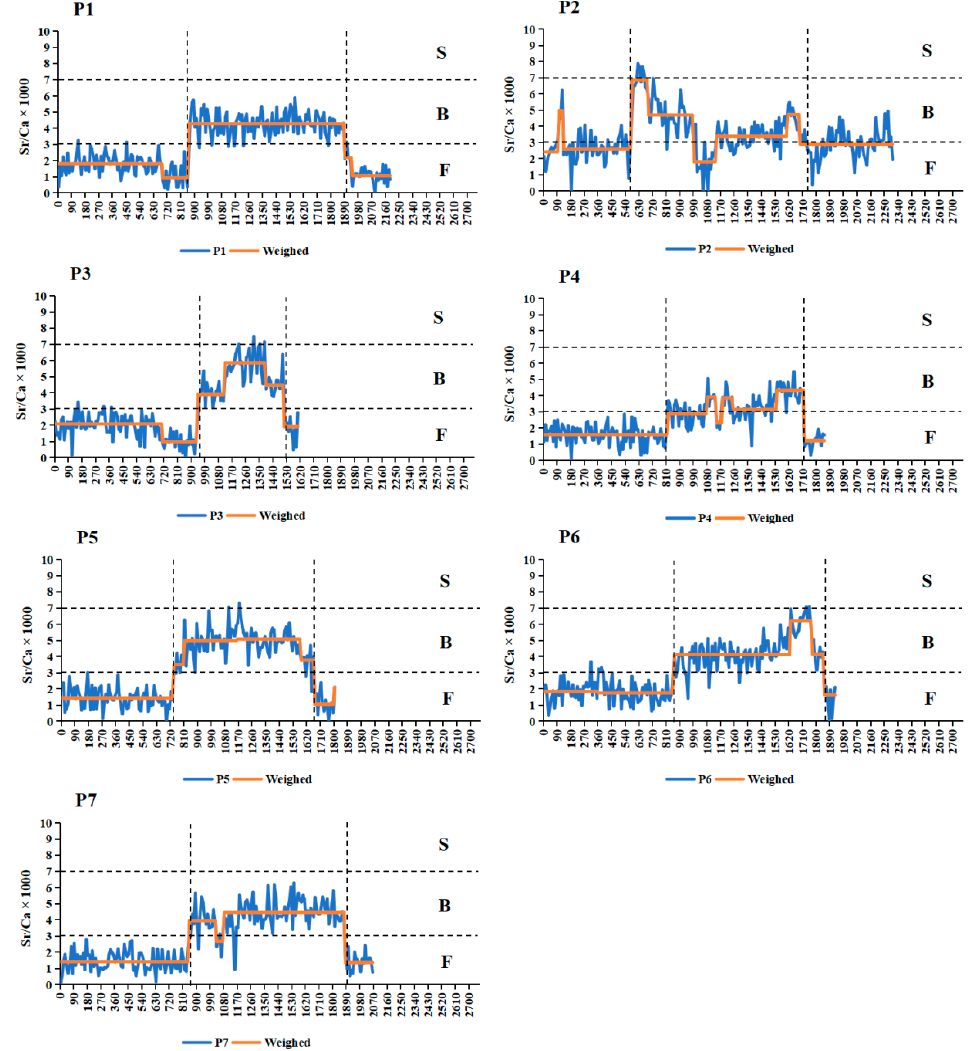
Figure 5. Fluctuation in otolith Sr/Ca ratios along line transects from the core (0 µ m) to the edge in the sagittal plane of the otoliths of different Coilia nasus groups along and Poyang Lake. Orange solid line represents the Sr/Ca ratios after trend conversion; blue solid lines represent actual Sr/Ca ratios. S: seawater, B: brackish water, F: fresh water.